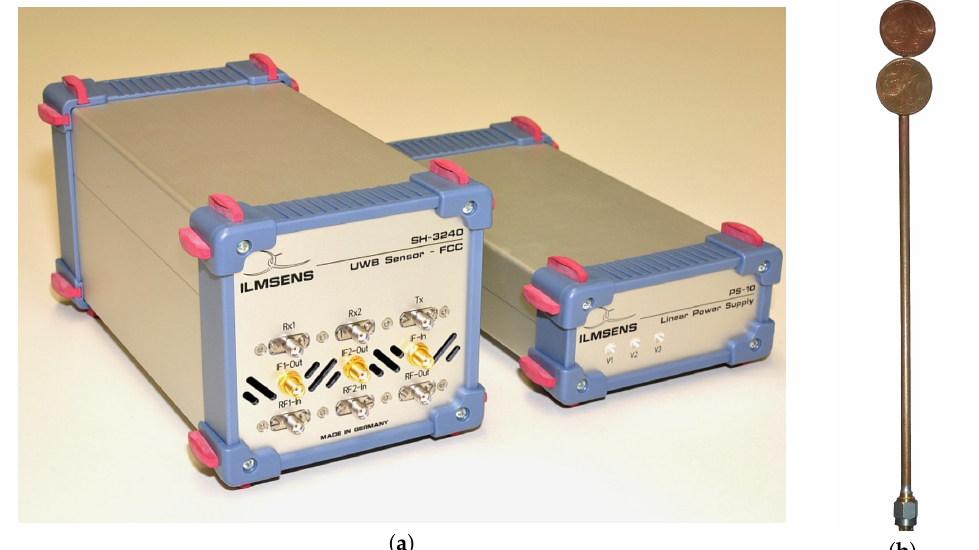
Figure 3. Equipments used for the experiment: ( a ) Ilmsens UWB M-sequence sounder and Ilmsens power supply, ( b ) coin